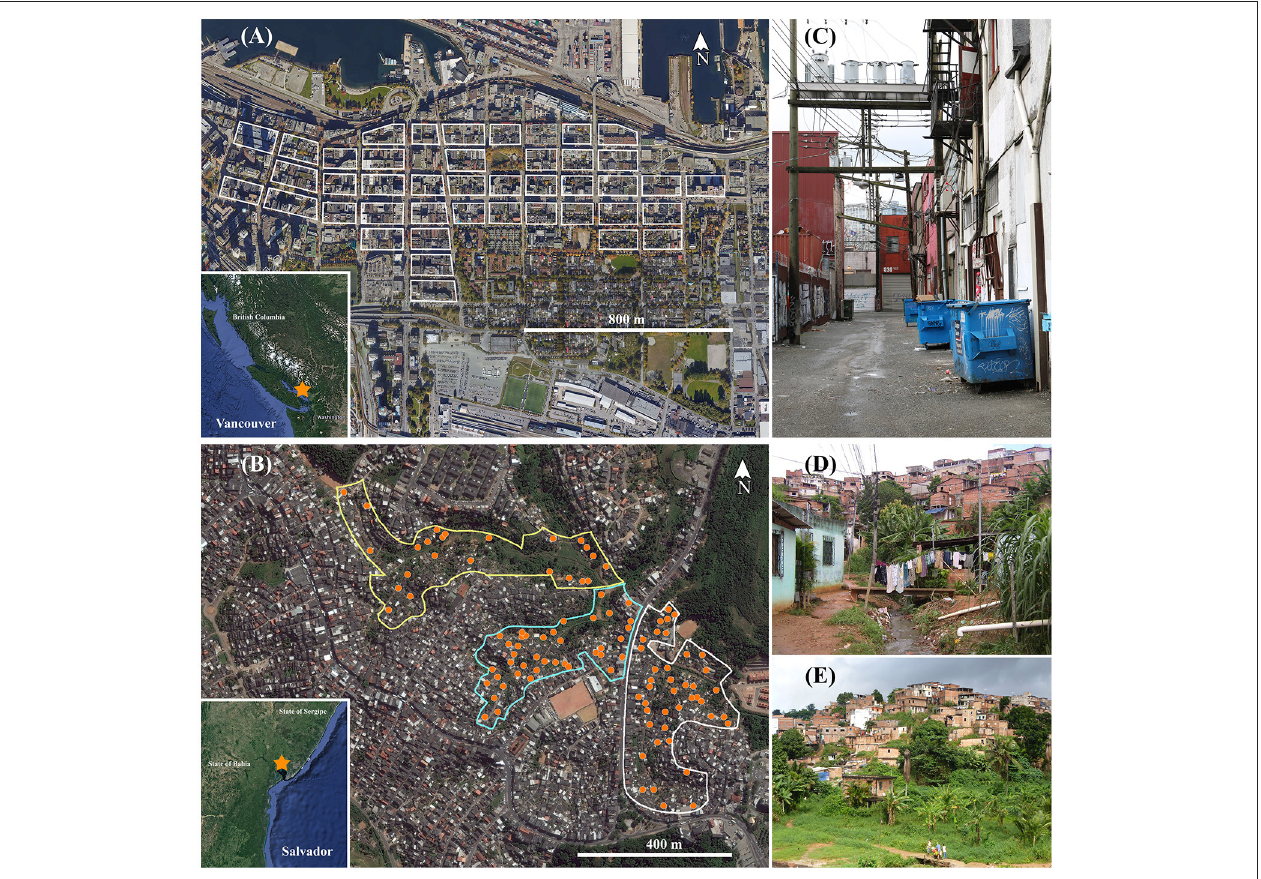
FIGURE 1 | Trapping locations in the 43 city blocks of Vancouver, Canada (A) and three valleys of Salvador, Brazil (B) . Images provided through Google Earth Professional (https://www.google.com/earth/download/gep/agree.html). Examples of areas where rats were caught in each location are indicated in (C) (Vancouver), (D,E)